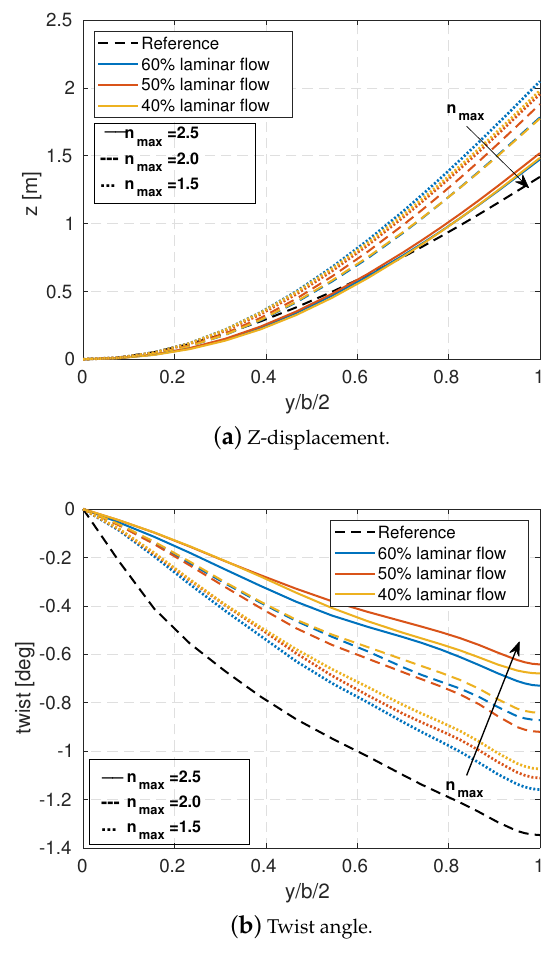
Figure 17. Backward-swept aeroelastic deformation. The deformed forward-swept wing configuration, optimised for n max =1.5, compared to the reference can be visualised in a 3d and a side view in Figure 18.